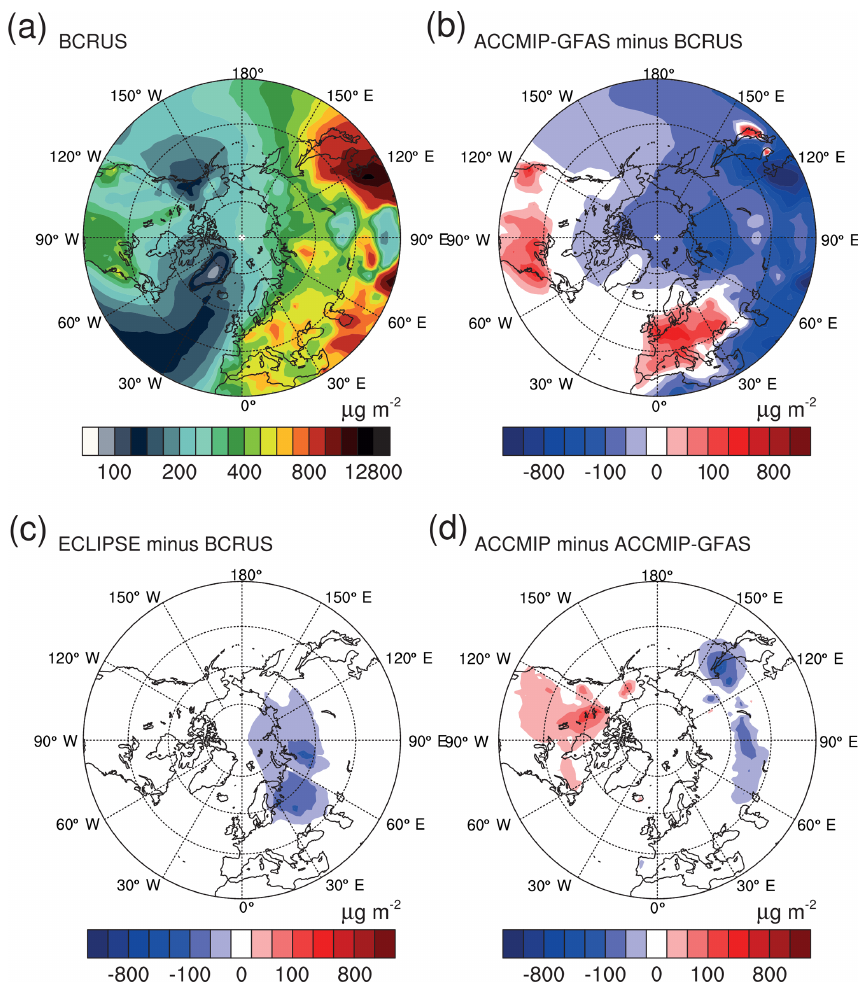
Figure 5. Contour plot showing the modeled atmospheric BC burden averaged over the simulation period (2005–2015). (a) Absolute values from the BCRUS setup, which is used as the reference. (b, c) Differences of ACCMIP-GFAS and ECLIPSE to the BCRUS run, respectively. Blue colors indicate lower BC burden than in the BCRUS run, and red indicates higher BC burden. (d) Difference in modeled atmospheric BC burden between ACCMIP and